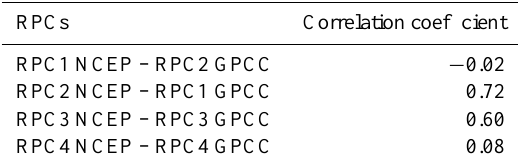
Table 4. Correlation coefficients between RPCs associated with the same sub-regions for NCEP/NCAR and GPCC datasets.